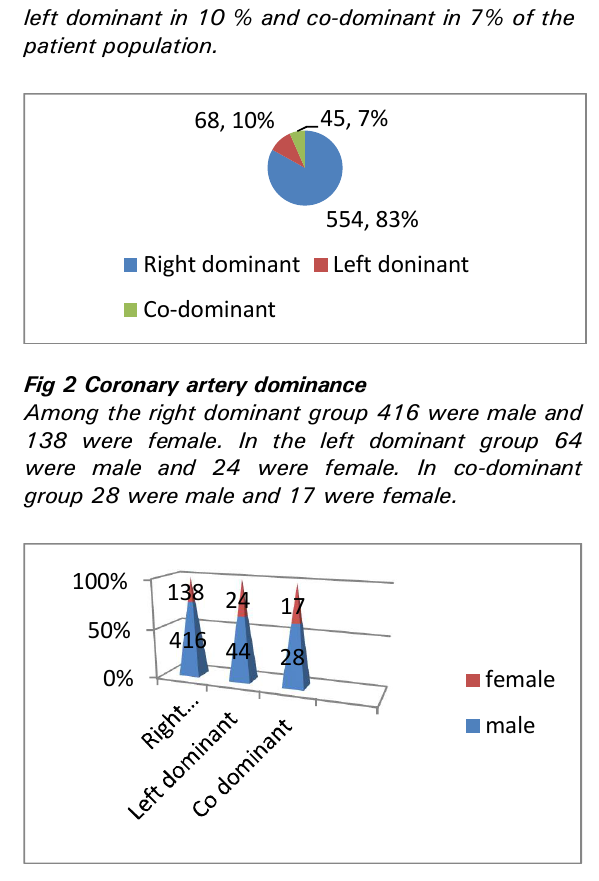
Fig 3. Gender wise distribution of coronary